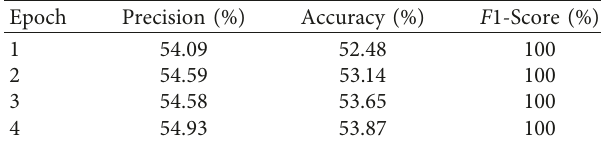
Figure 4: Accuracy on dataset II. Table 9: Effect of the number of iterations.